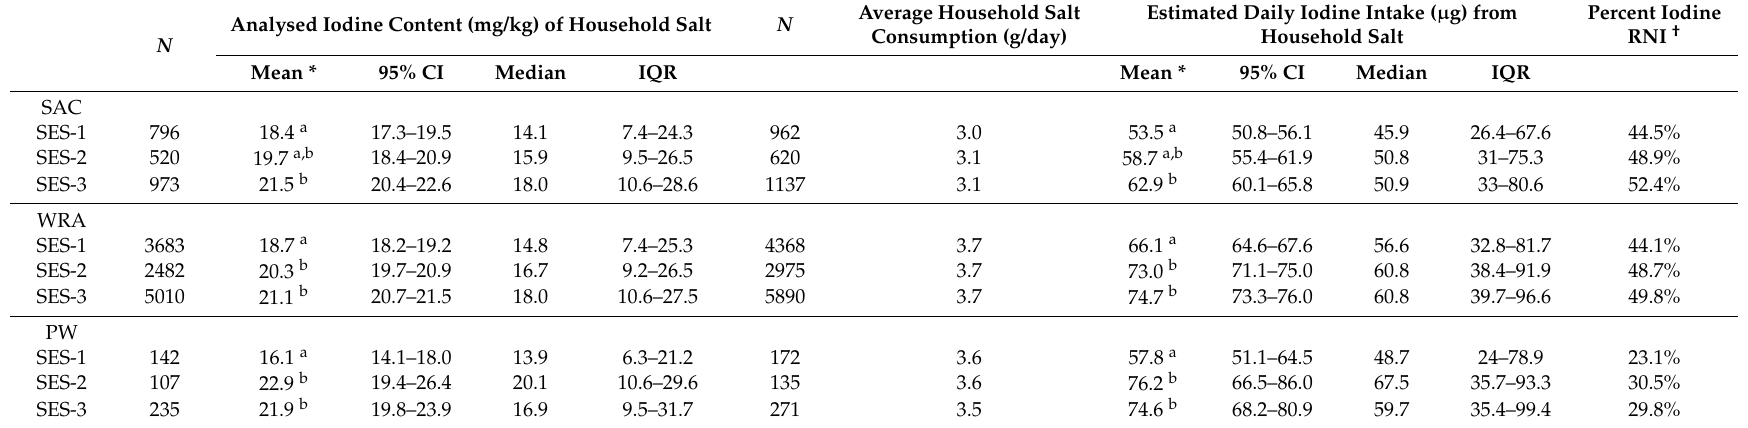
Table 8. Mean and median iodine contents of household salt (mg/kg) and estimated daily iodine intakes ( µ g) and percentages of RNI from household salt by household SES